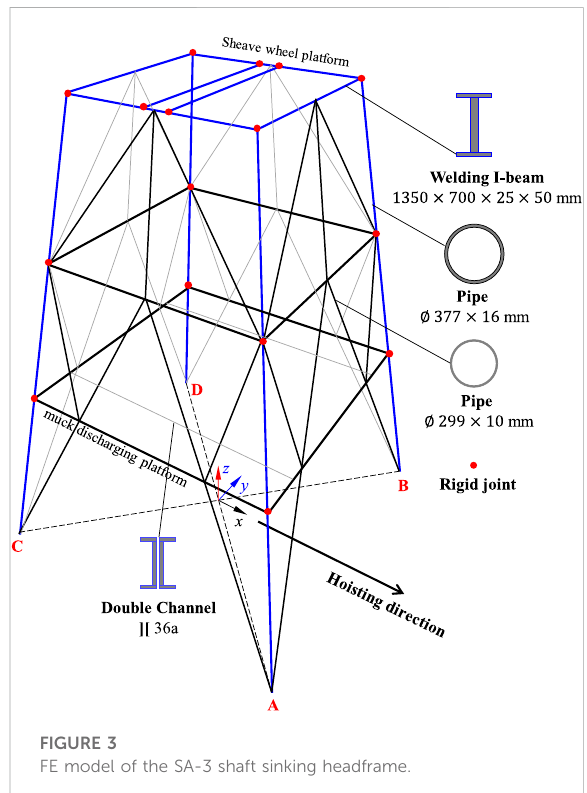
FIGURE 3 FE model of the SA-3 shaft sinking headframe.